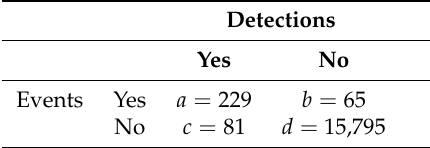
Table 1. Contingency table for WER